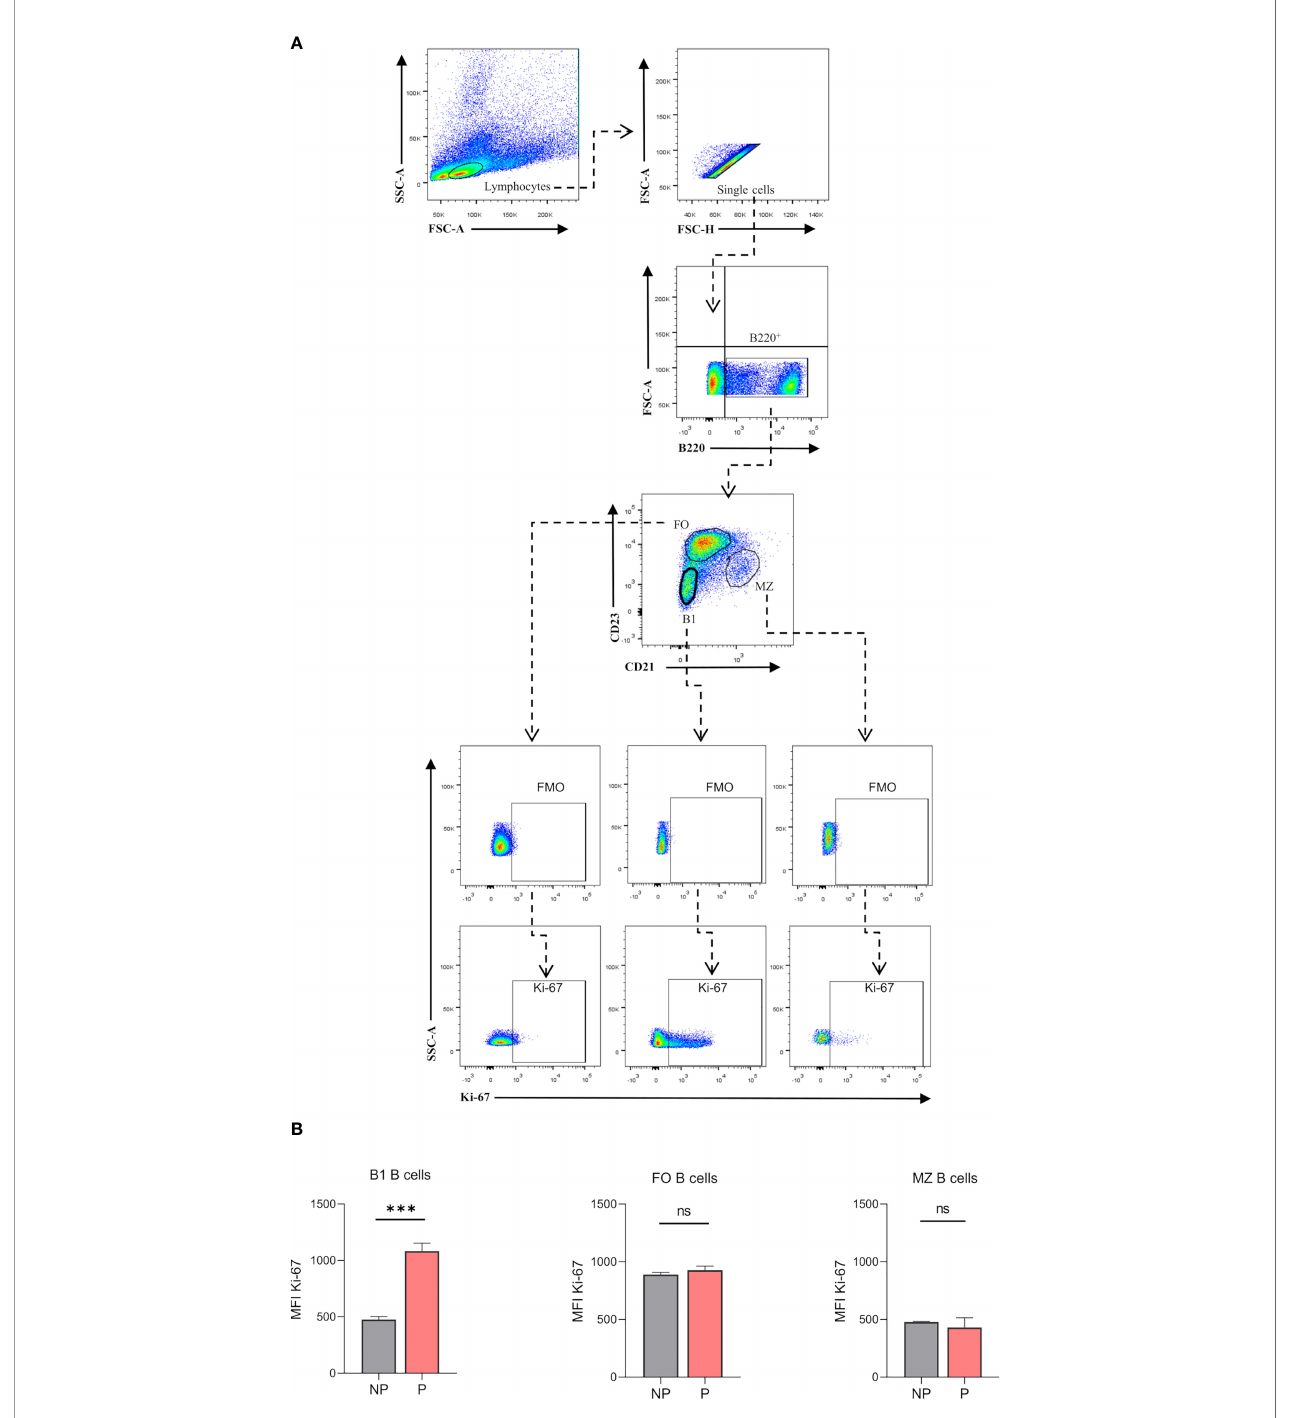
FIGURE 4 | (A) . Gating strategy to evaluate proliferation marker Ki-67 on splenic B cell subsets. Representative pseudocolor plots showing gating strategy used to quantify Ki-67 expression of B cell subsets in the spleen of pregnant (P) and non-pregnant (NP) mice. Lymphocytes were gated by FSC vs. SCC, doublets were eliminated and B220 was used to de fi ne the total B cell population in the spleen. Auto- fl uorescence of each biological replicate was used as a negative control for B220. Additionally, Ki-67 expression was analyzed in B1 (B220 + CD23 - CD21 - ), FO (B220 + CD23 + CD21 - ), and MZ (B220 + CD23 - CD21 high ) B cells, using fl uoresce minus one (FMO) as control. Back gating of B1 B cells showed 95% of cells with low expression of B220 (B220 low CD23 - CD21 - ), while B2 B cells showed high expression levels of B220 marker (data not shown). (B) . Analysis of Ki-67 expression on B cell subsets. Ki-67 (MFI) on splenic B1 B cells was signi fi cantly increased in P (1083±41.2; n=3) as compared to NP (476.3±14,6; n=3) mice. Splenic B2 B cells showed no signi fi cant differences in Ki-67 MFI from P compared to NP mice. Unpaired Student ’ s t-test ( a =0.05), ns= no signi fi cant, (***)